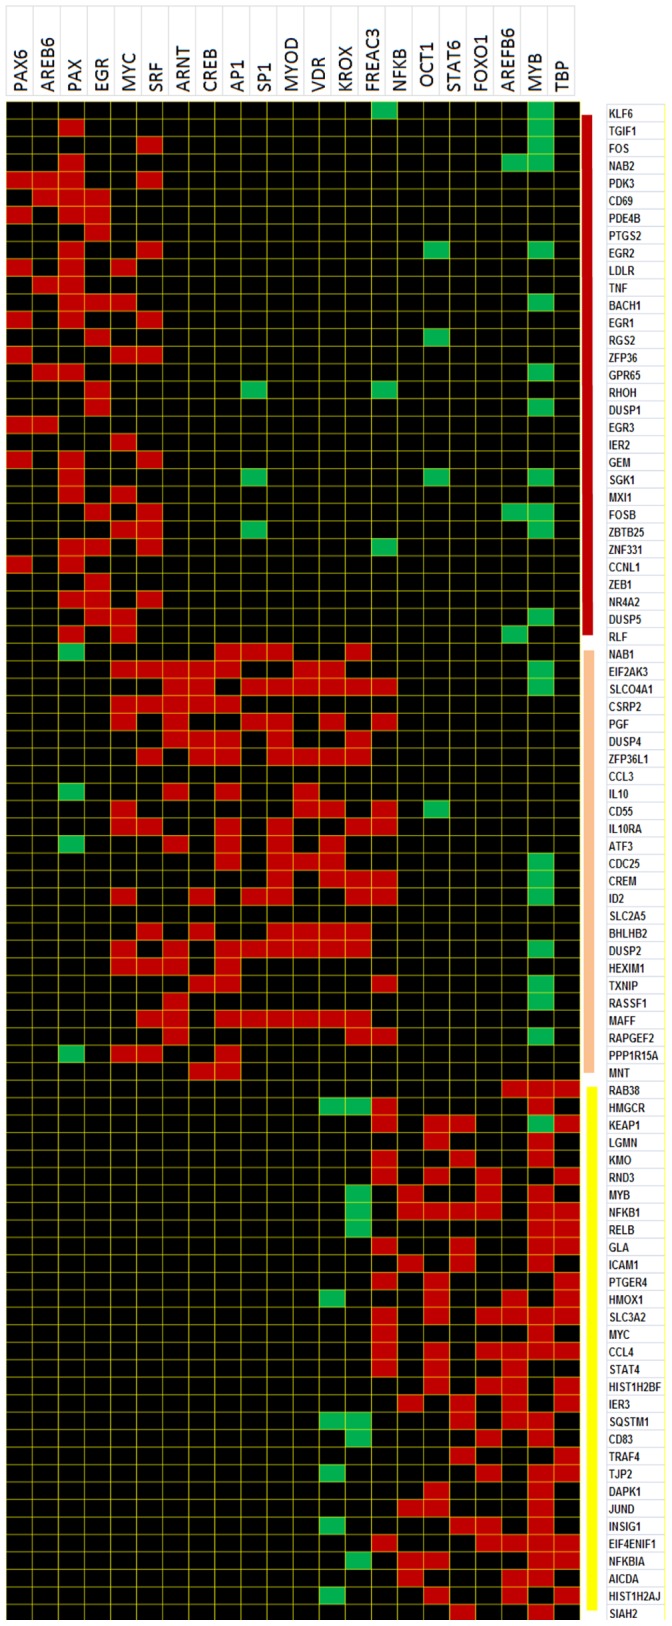
Transcription factor analysis of the variable gene clusters.Transcription factors tested are presented at the top of the diagram. The cluster content is shown along the right. Individual elements of the matrix are colored by the significance of the p-values (threshold p = 0.05): over-representation in the matrix is indicated in red, under-representation is indicated in green.